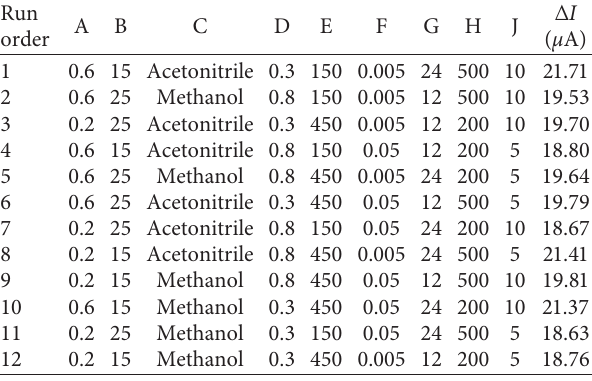
Table 1: Results of PB experimental design matrix. Run A B C order